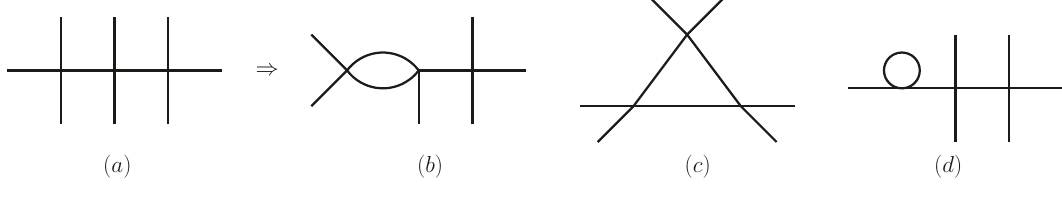
Figure 6 . From 8-point tree topology to 6-point 1-loop topologies. (d) should be removed because it contains a snail subgraph, therefore it has no contribution to the UV